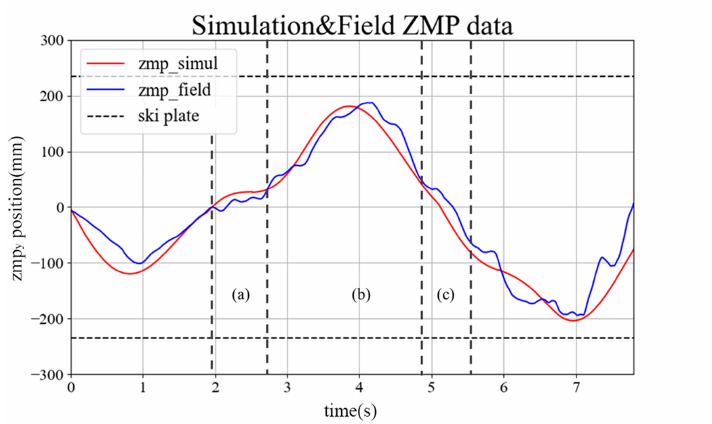
Figure 18. Comparison of ZMP y based on simulation and field test